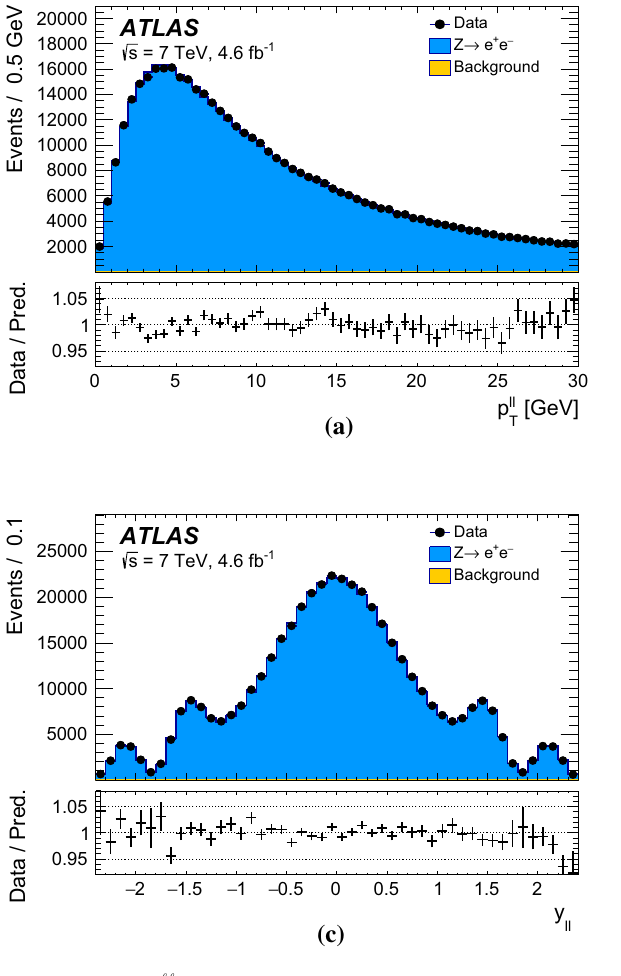
Background events contribute less than 0.2% of the observed distribu- tions.Thelowerpanelsshowthedata-to-predictionratios,withtheerror bars showing the statistical